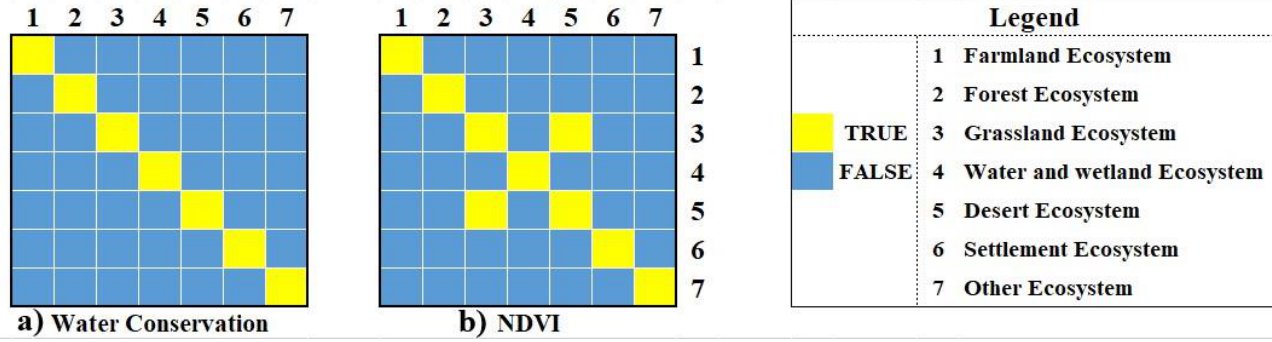
Figure 6. Significant differences between the means of two ecosystem types for ( a ) water conservation and ( b ) the NDVI by a risk detector. “TRUE” indicates a significant difference exists ( t -test with p < 0.05); otherwise, it is “FALSE.”